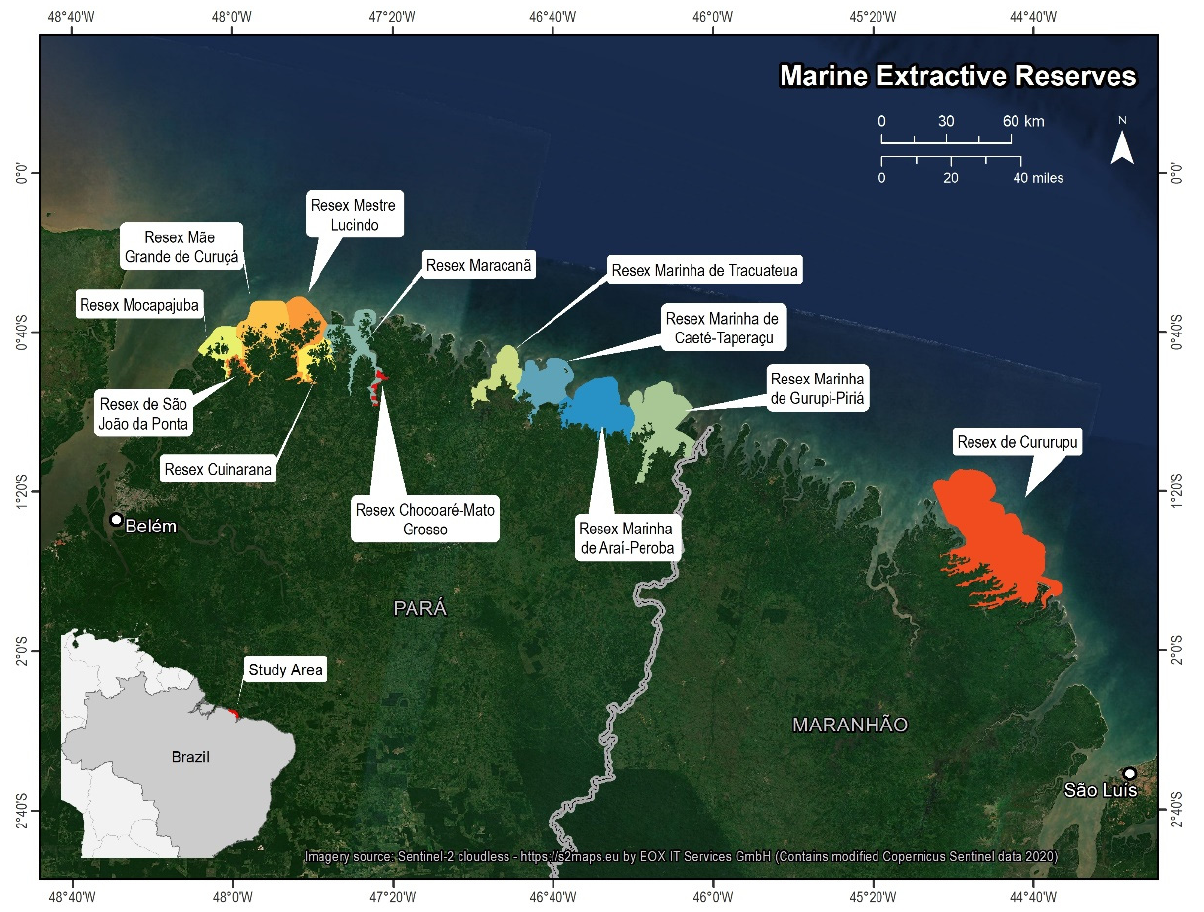
Figure 1. Study area located on the northern coast of Brazil (area in red on insert map, bottom left), straddling the states of Pará to the west and Maranhão to the east. The 12 Extractive Reserves (MERs) or Reserva Extrativistas (Resex) are depicted in a separate color and labelled. Imagery Source: Copernicus Sentinel 2 cloudless mosaic https://s2maps.eu by EOX IT services GmbH.